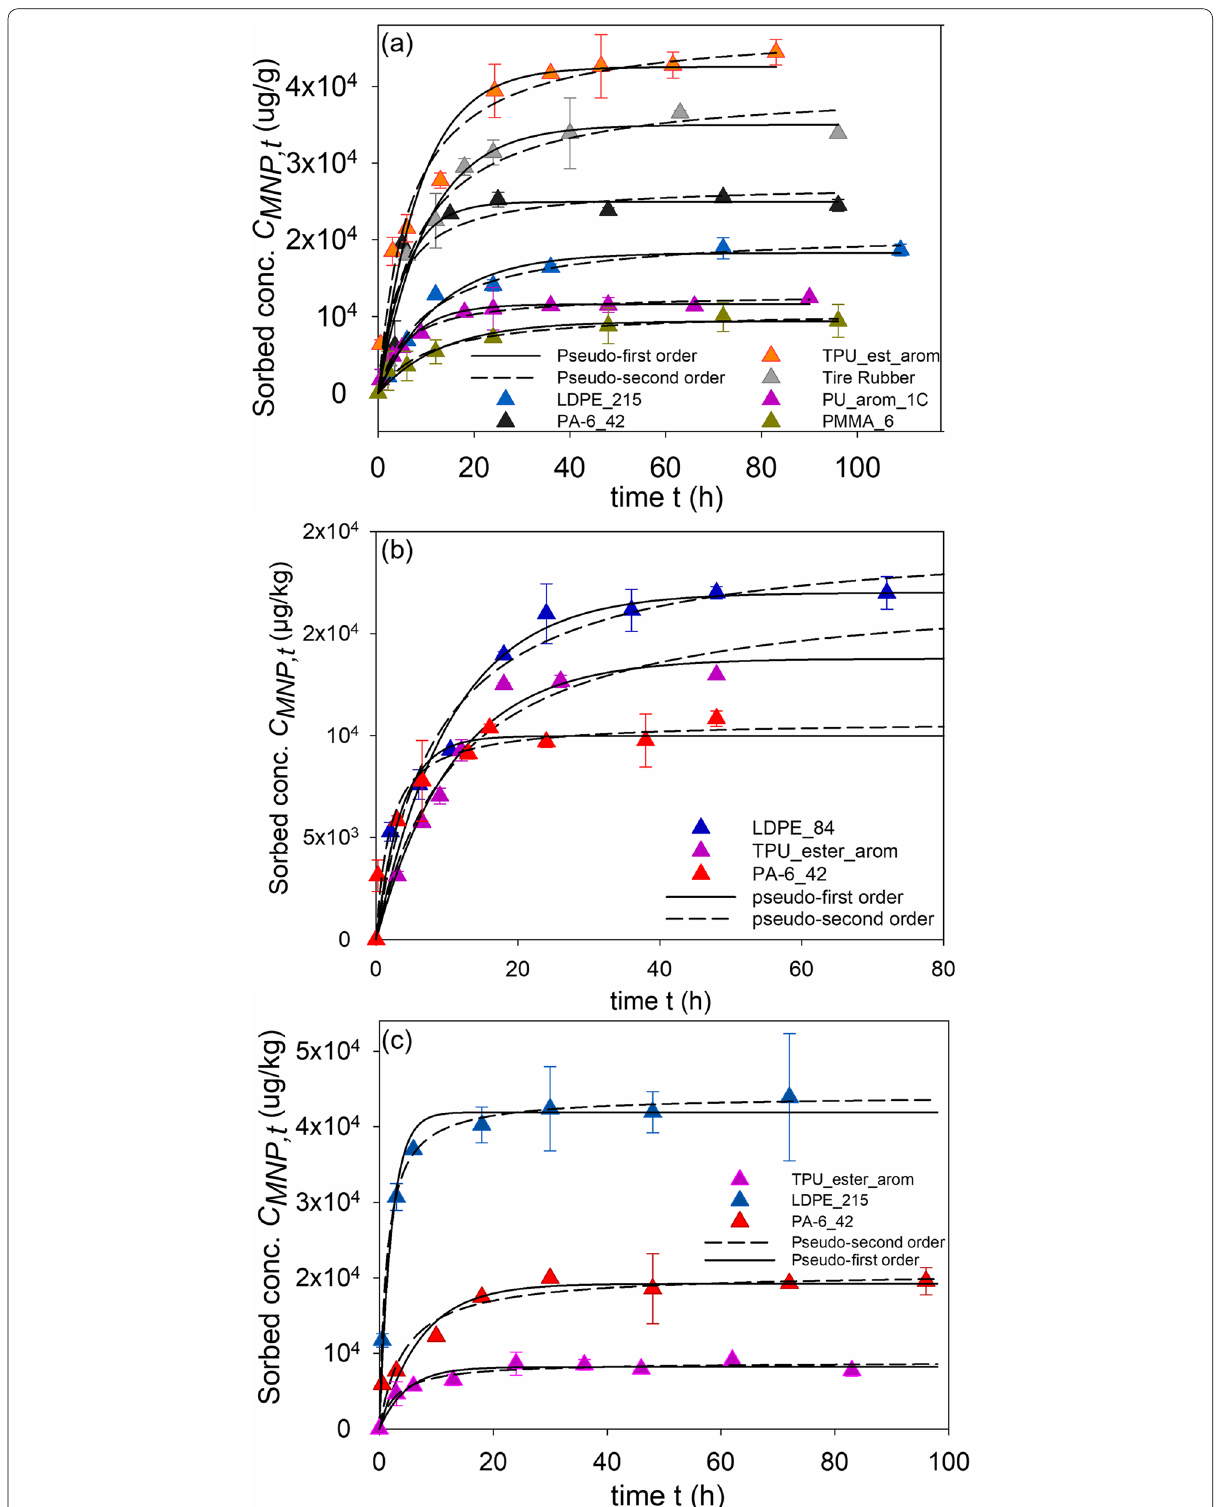
Fig. 2 Sorption kinetics of ( a ) B[ a ]P, ( b ) Anth and ( c ) DB[ a,l ]P and selected MNPs ( n kinetics models. See Table S3 for model parameters and calculated rate